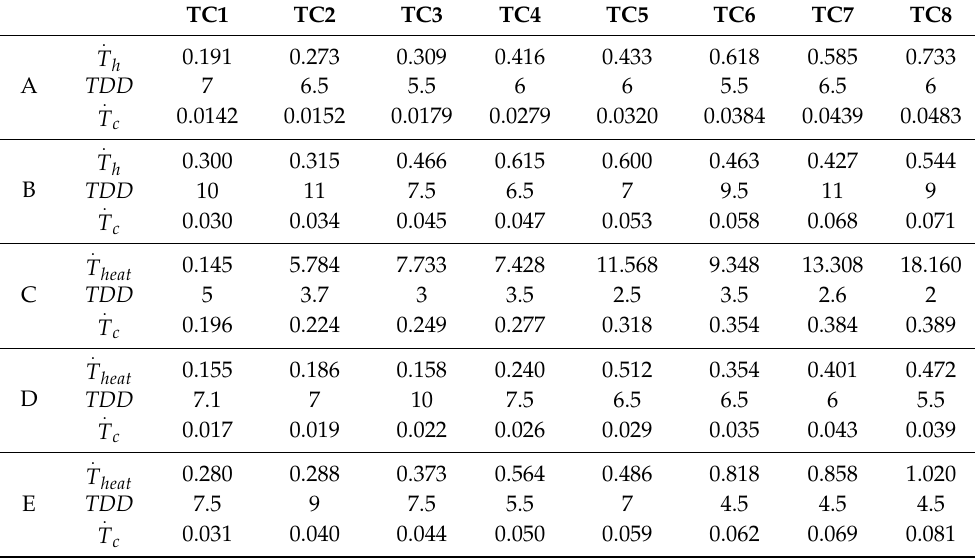
Table 5. Summary of sampling points heating rates (°C ∙ s − 1 ) and thermal diffusion distances (mm) along the manifesting region.